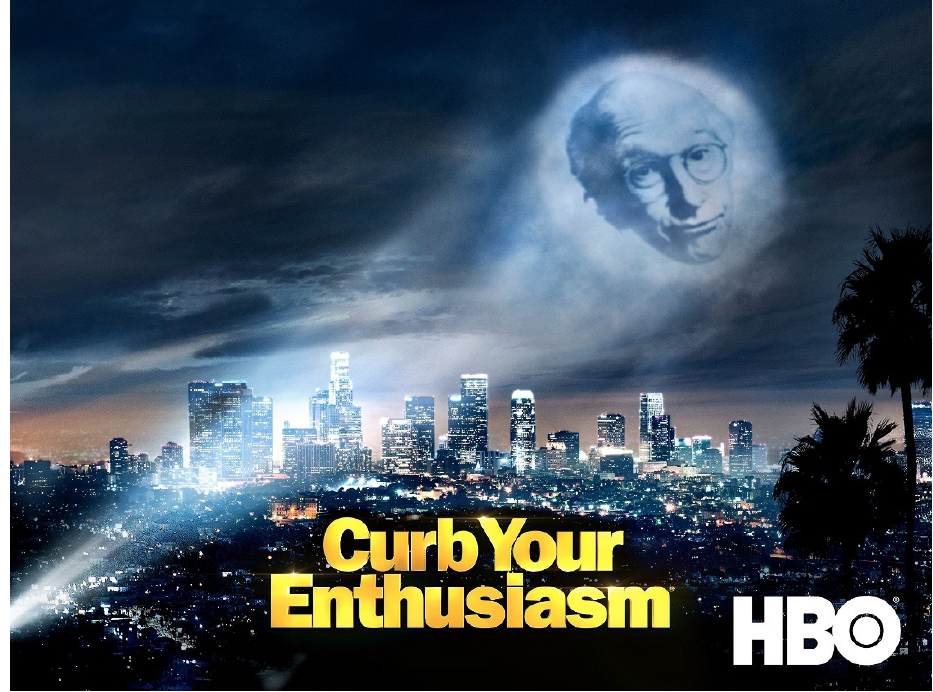
Figure 2. Larry David’s reluctant vigilantism (poster HBO’s Curb Your Enthuasism ).